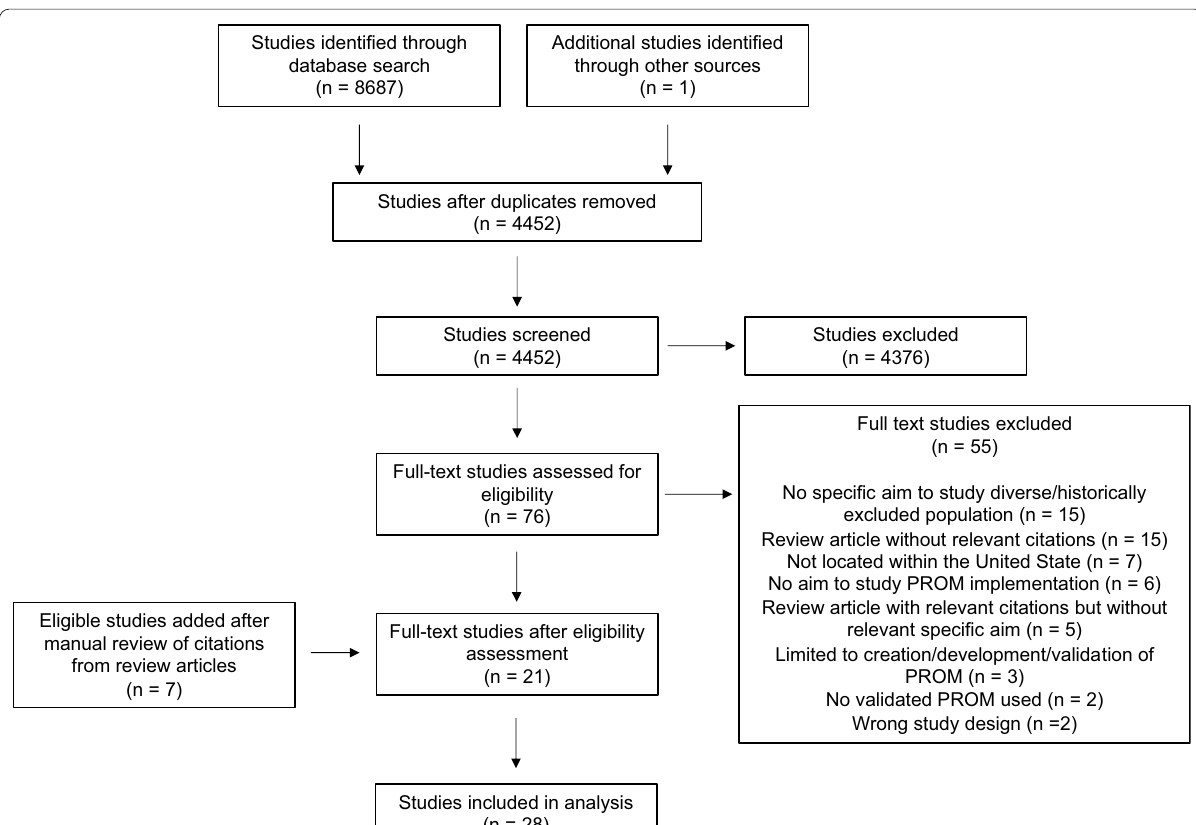
Fig. 1 Preferred Reporting Items for Systematic Reviews and Meta-Analyses for Scoping Reviews (PRISMA-ScR) diagram detailing inclusion and exclusion of studies included in the